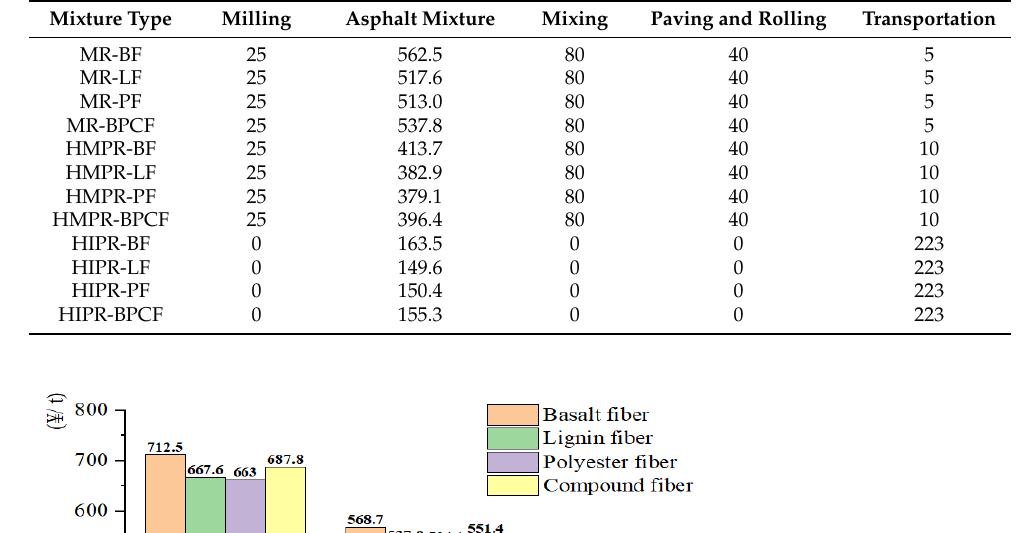
Table 14. Cost details of each maintenance process.